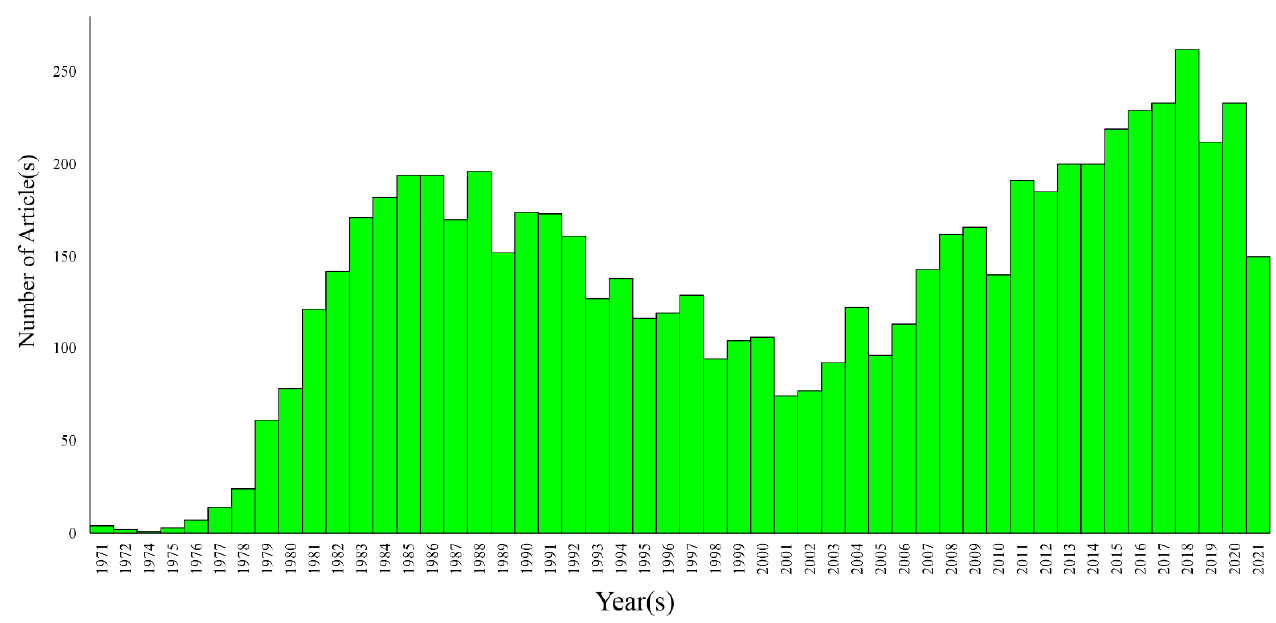
Figure 2. Number of articles published between 1971 and 2021 that used Tunicamycin in all studies. The information was collected from PubMed (https://pubmed.ncbi.nlm.nih.gov (accessed on 26 September 2021)). Search query: Tunicamycin.